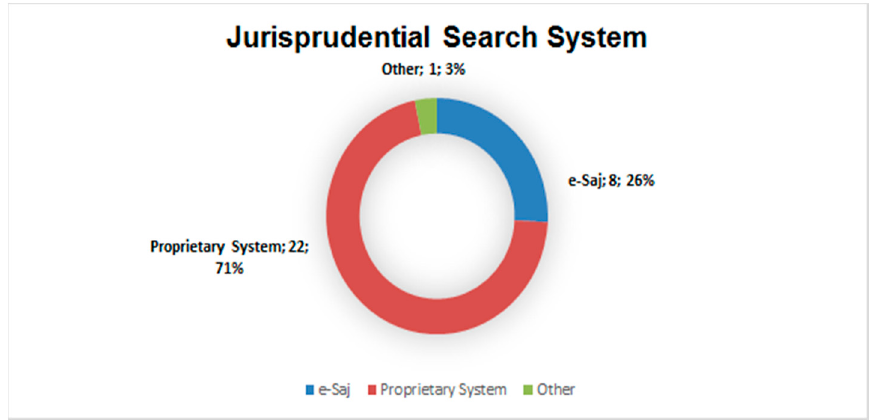
Figure 1. Distribution of jurisprudential search engines regarding how they were developed.